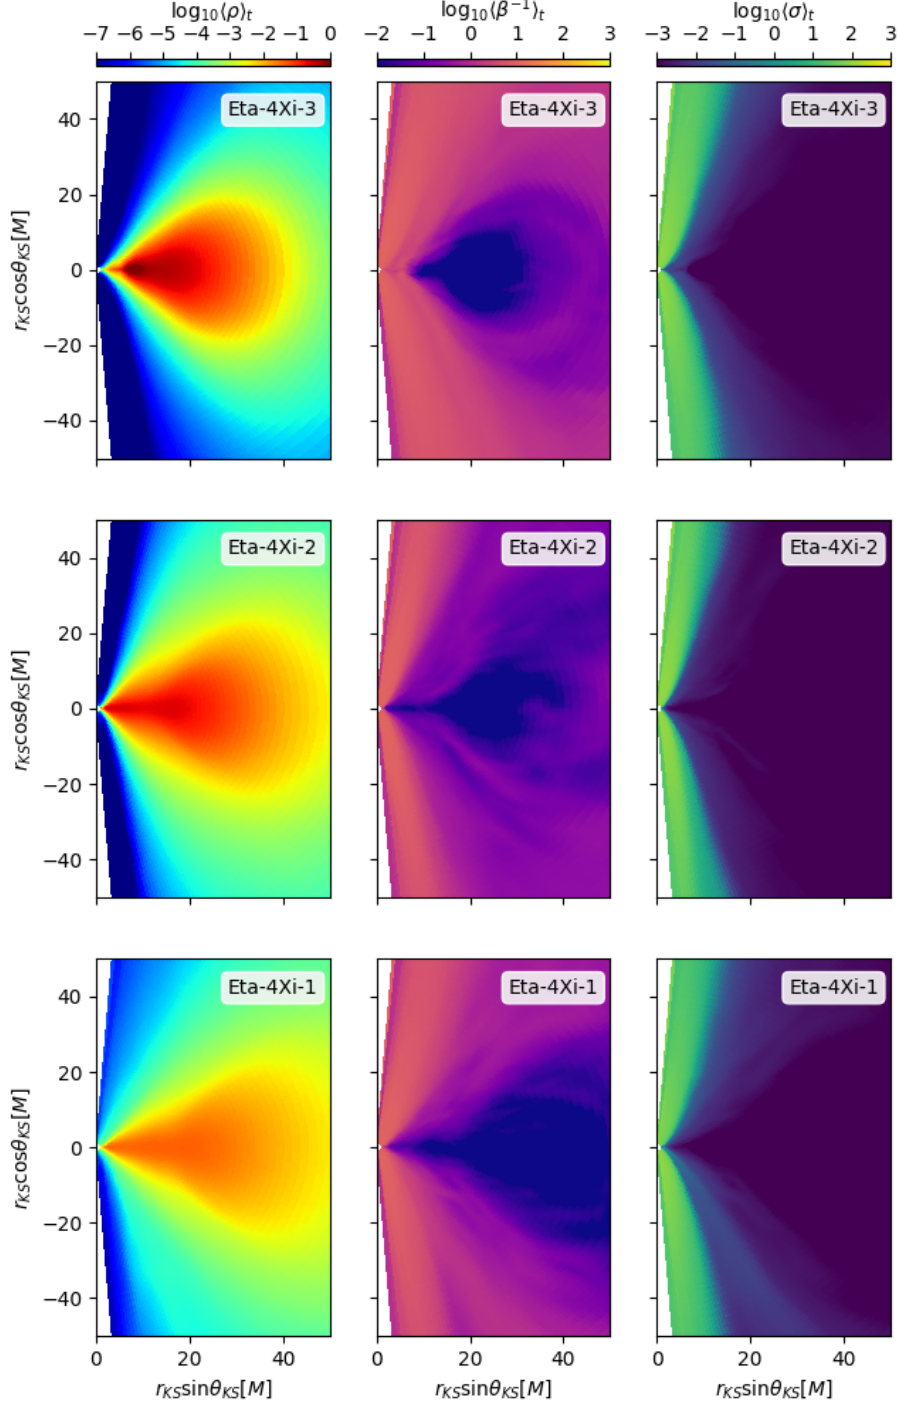
Figure 6. Time-averaged data for rest-mass density, inverse plasma β , and magnetization for runs with η 0 = 10 − 4